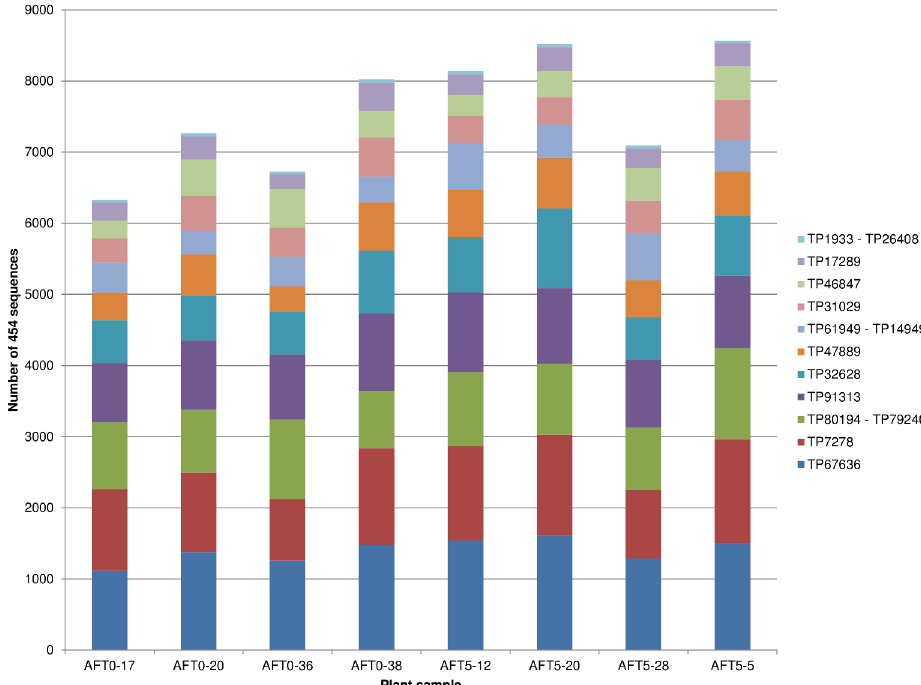
Fig 2. Number of 454 sequences retained for each of 11 amplicons covering 14 SNP loci identified with UNEAK in eight plant samples.